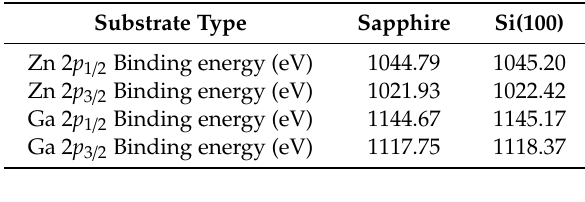
Figure 6. Binding energy spectra of ( a ) Zn 2 p and ( b ) Ga 2 p for the ZnGa 2 O 4 thin films deposited on di ff erent substrates. Table 1. Binding energies of Zn 2 p 3 / 2 , Zn 2 p 1 / 2 , Ga 2 p 3 / 2 , and Ga 2 p 1 / 2 in ZnGa 2 O 4 thin films deposited on sapphire and Si(100).